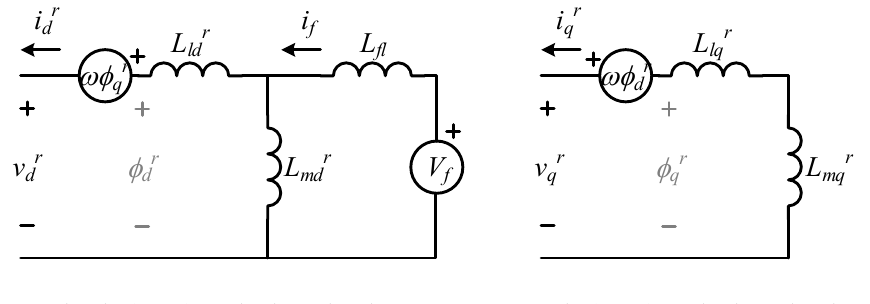
Figure 1. Equivalent dynamic model of SG seen at stator side in the dq frame set on the